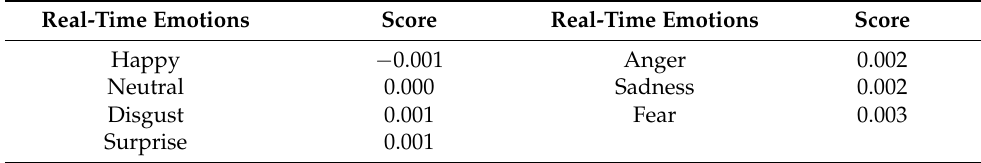
Table 2. Real-time sentiment score table.